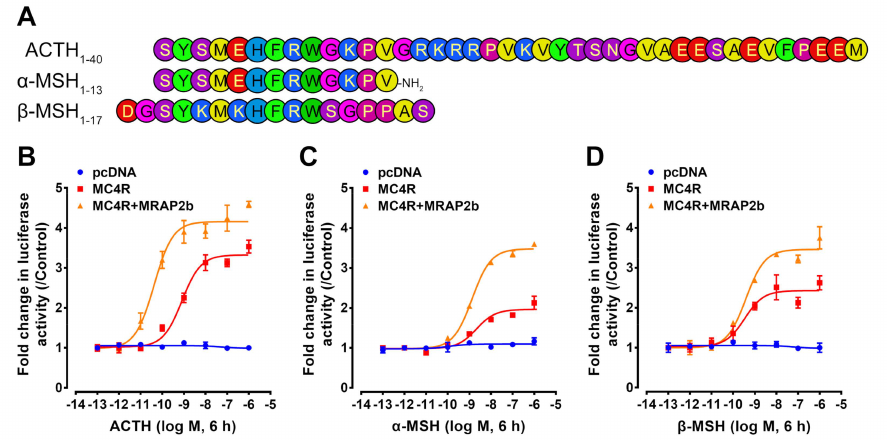
Figure 5. E ff ect of tilapia ACTH, α -MSH, and β -MSH in activating MC4R in the absence or presence of MRAP2b. ( A ) Sequences of tilapia ACTH, α -MSH, and β -MSH used in this study. The colors indicate